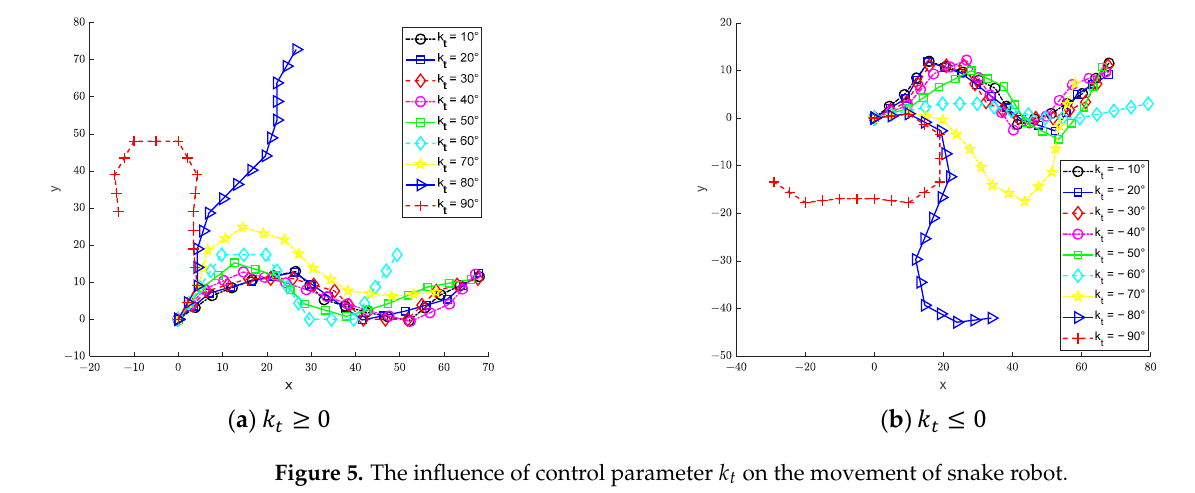
Figure 5. The influence of control parameter k t on the movement of snake robot.